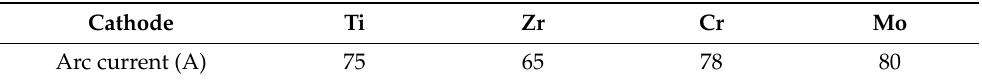
Table 2. Main parameters of the coating deposition process at pressure N 2 0.42 Pa and voltage of substrate − 150 V (DC) .